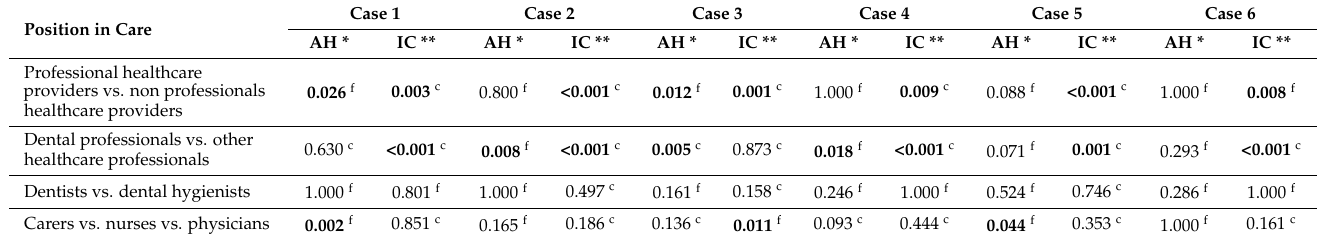
Table 4. p -values of statistical analyses of Cases 1 to